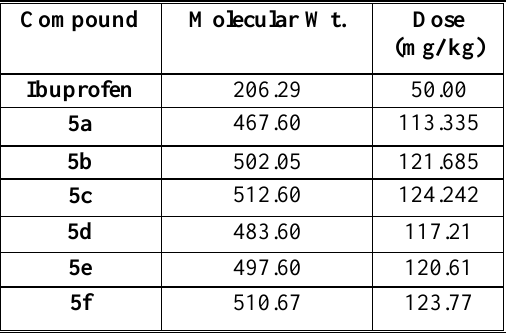
compound 5f : Colour: red powder. Yield: